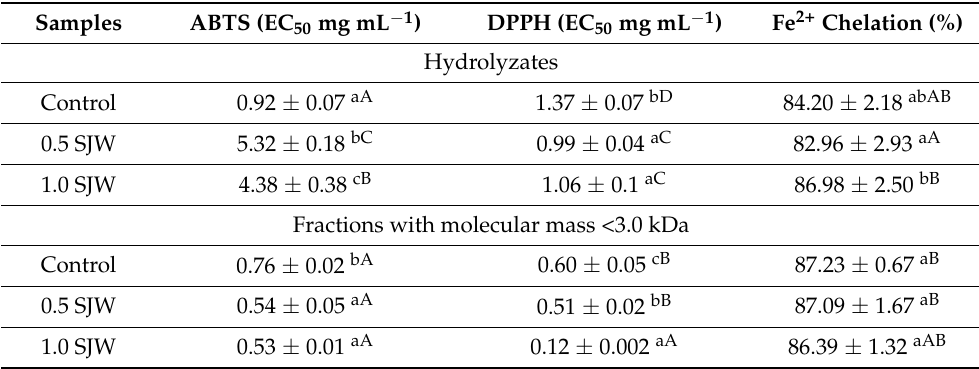
Table 4. Antioxidant properties of hydrolyzates and fractions with molecular mass <3.0 kDa.